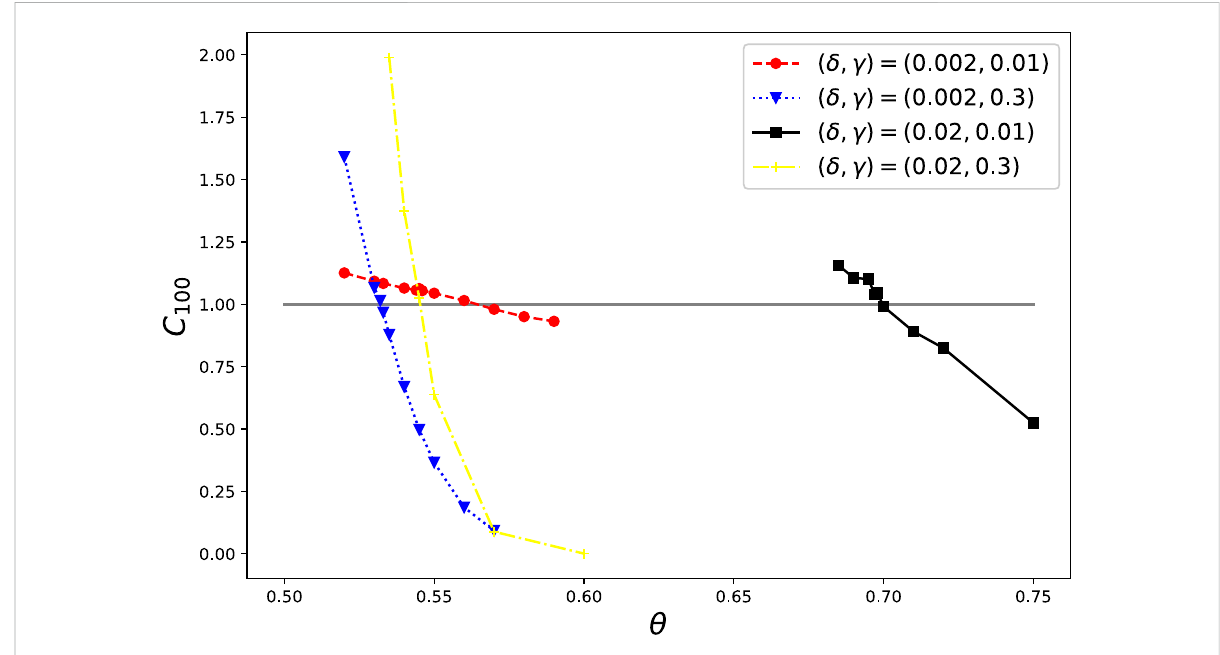
FIGURE 2 Effects of thenetwork density ( γ )and trust structure ( θ , δ )on theconvergence of opinions in the L r type(random graph) ofinteraction structure. Here,theparameterswere(| N |, α , β , κ )=(1,600,1,10,10),andthefourcasesof( γ , δ )=(0.01,0.002)(0.3,0.002)(0.01,0.02),and(0.3,0.02)areshown. The horizontal axis indicates the value of θ , while the vertical axis indicates the average value of C 100 for 10 trials with different random